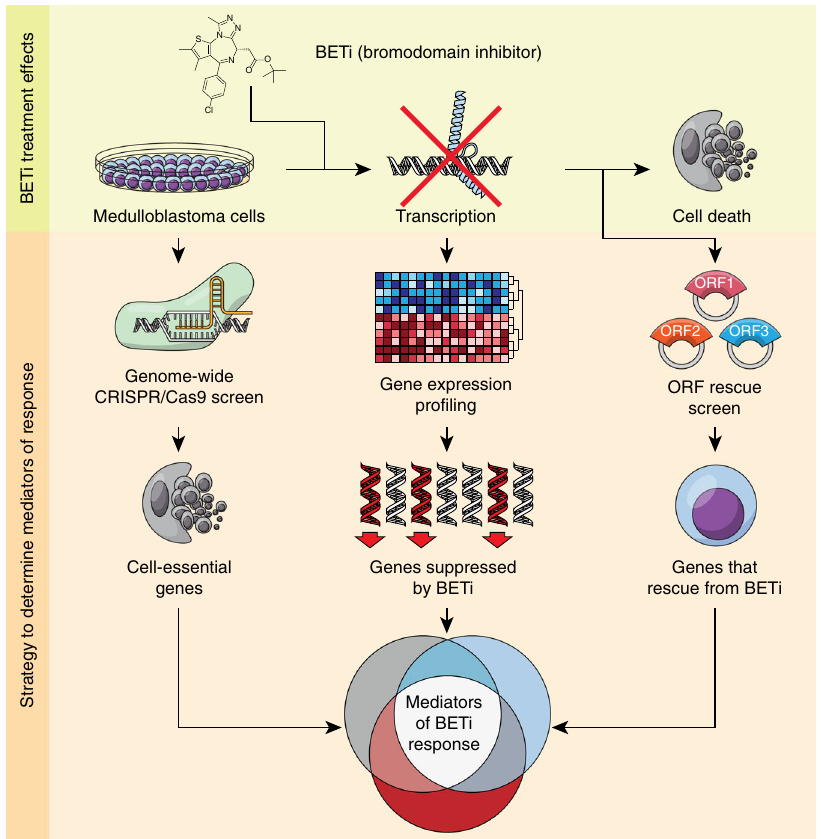
Fig. 1 Integrative genomic analysis to identify mediators of BETi response. Schematic depicting overall analysis. Top panel: Treatment of medulloblastoma cells with BETi results in transcriptional suppression, contributing its phenotypic effects. Bottom panel: Integrative genomics approach incorporating genome-scale CRISPR-Cas9 screens to identify cell-essential genes, expression pro fi ling following treatment with BETi to identify genes suppressed by BETi, and near genome-scale ORF rescue screens to identify genes that are required to be suppressed for BETi to exert its functional effect. The combination of all three assays identi fi es cell-essential genes that are suppressed by BETi, and whose suppression is necessary for decreased viability,